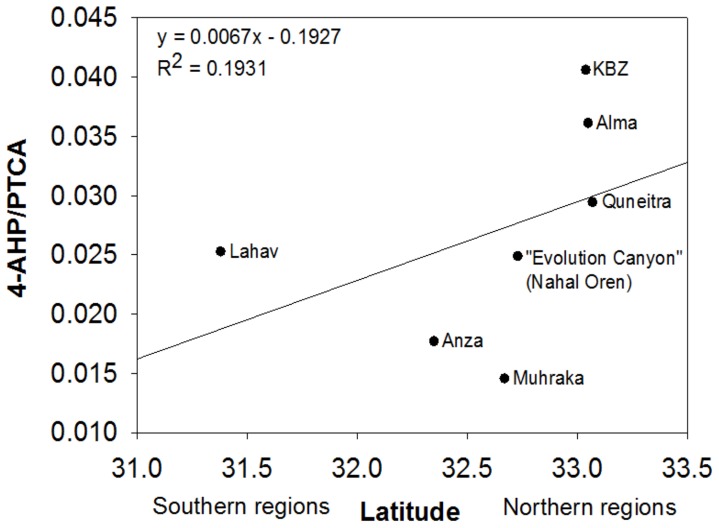
Pheomelanin/eumelanin ratio among Spalax populations across latitude.